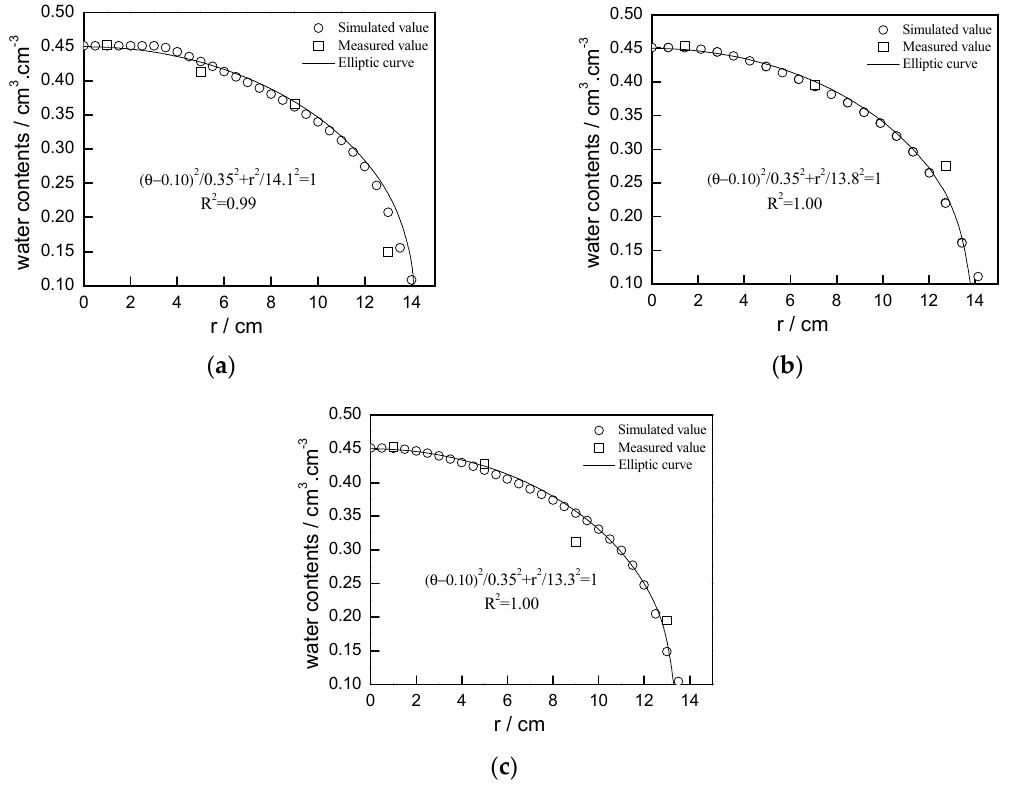
Figure 6. Water content distribution of the wetting body radius of Xi’an silt loam after irrigation for 360 min: ( a ) β = 0 ° ; ( b ) β = 45 ° ; ( c ) β = 90 ° .